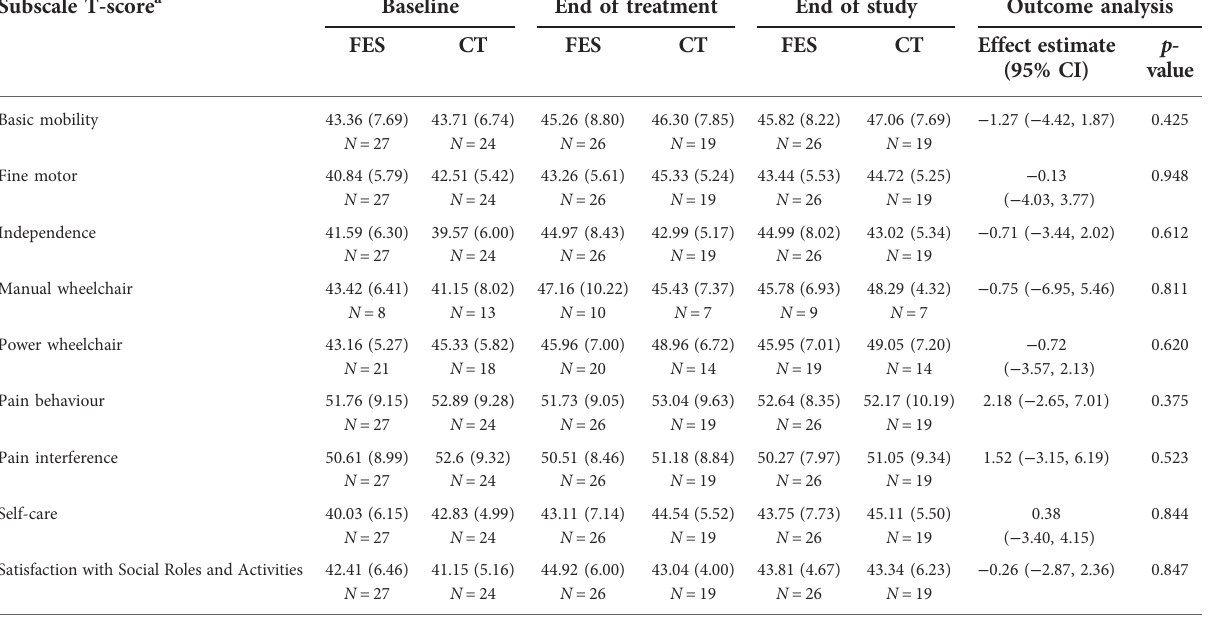
TABLE 8 SCI-QoL.